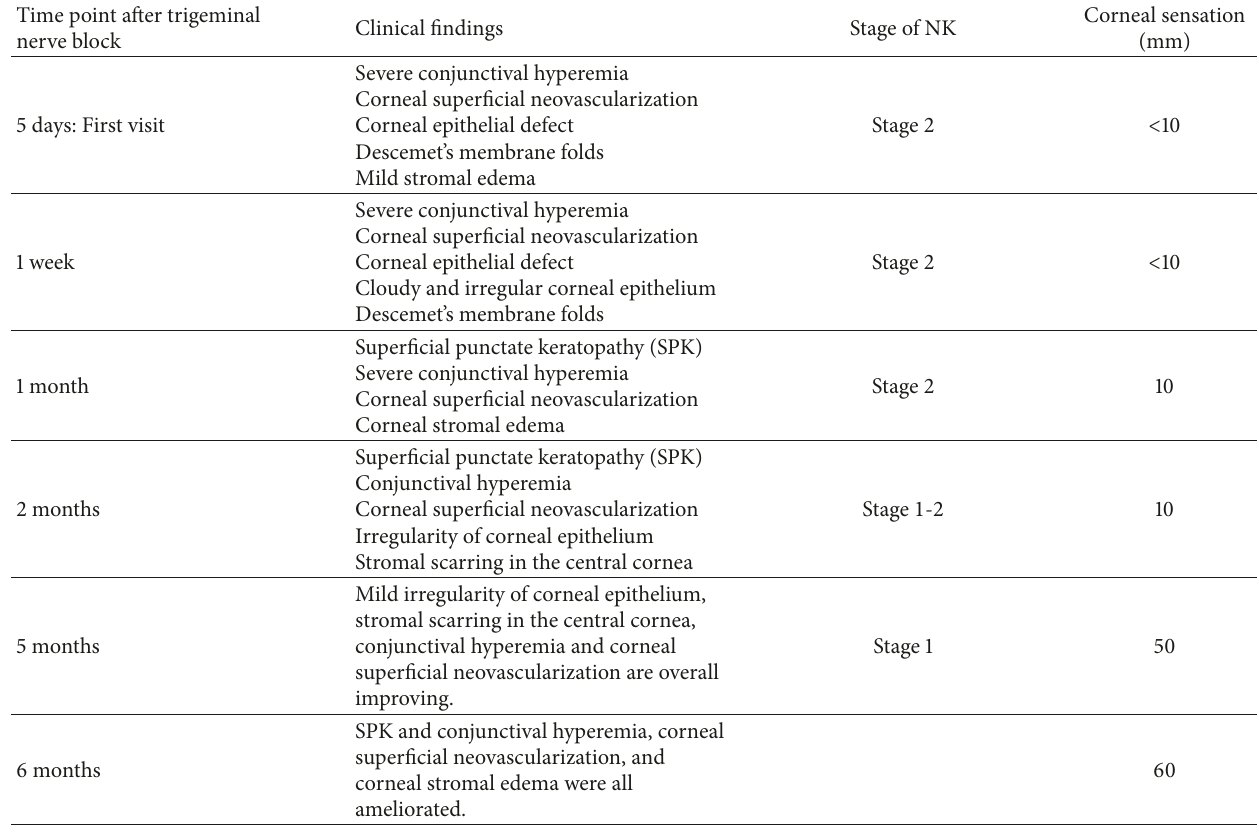
Table 1: Details of the clinical findings of the right